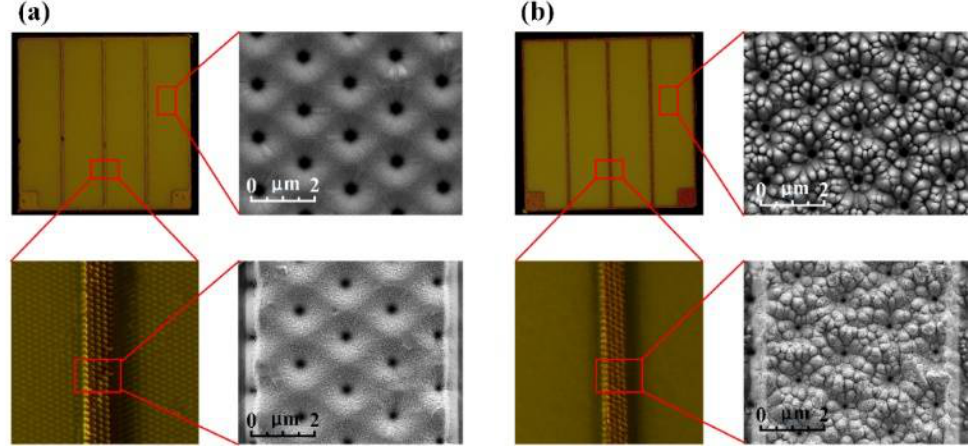
Figure 4. Optical microscope images and SEM images of surface morphology on n-GaN layer ( a ) without KOH etching and ( b ) with KOH etching.